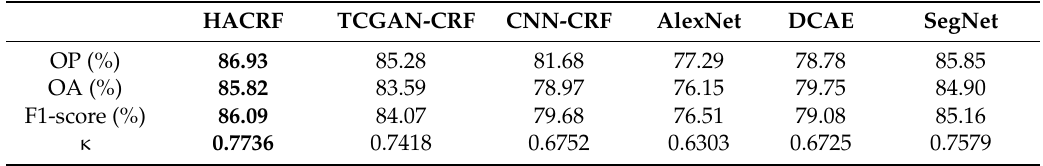
Table 3. Comparison of the overall segmentation performance with five state-of-the-art methods. HACRF TCGAN-CRF CNN-CRF AlexNet DCAE SegNet